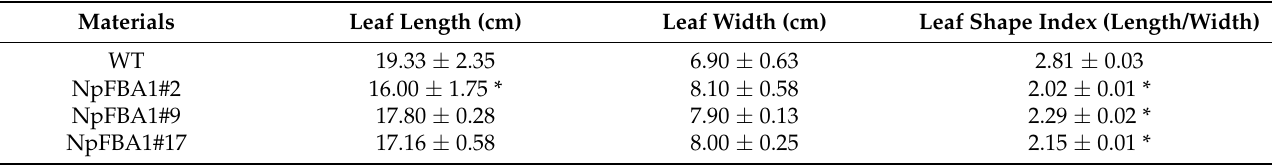
Table 1. Comparison of leaf length, width and leaf shape index of NpFBA1 -overexpressing and WT plants.